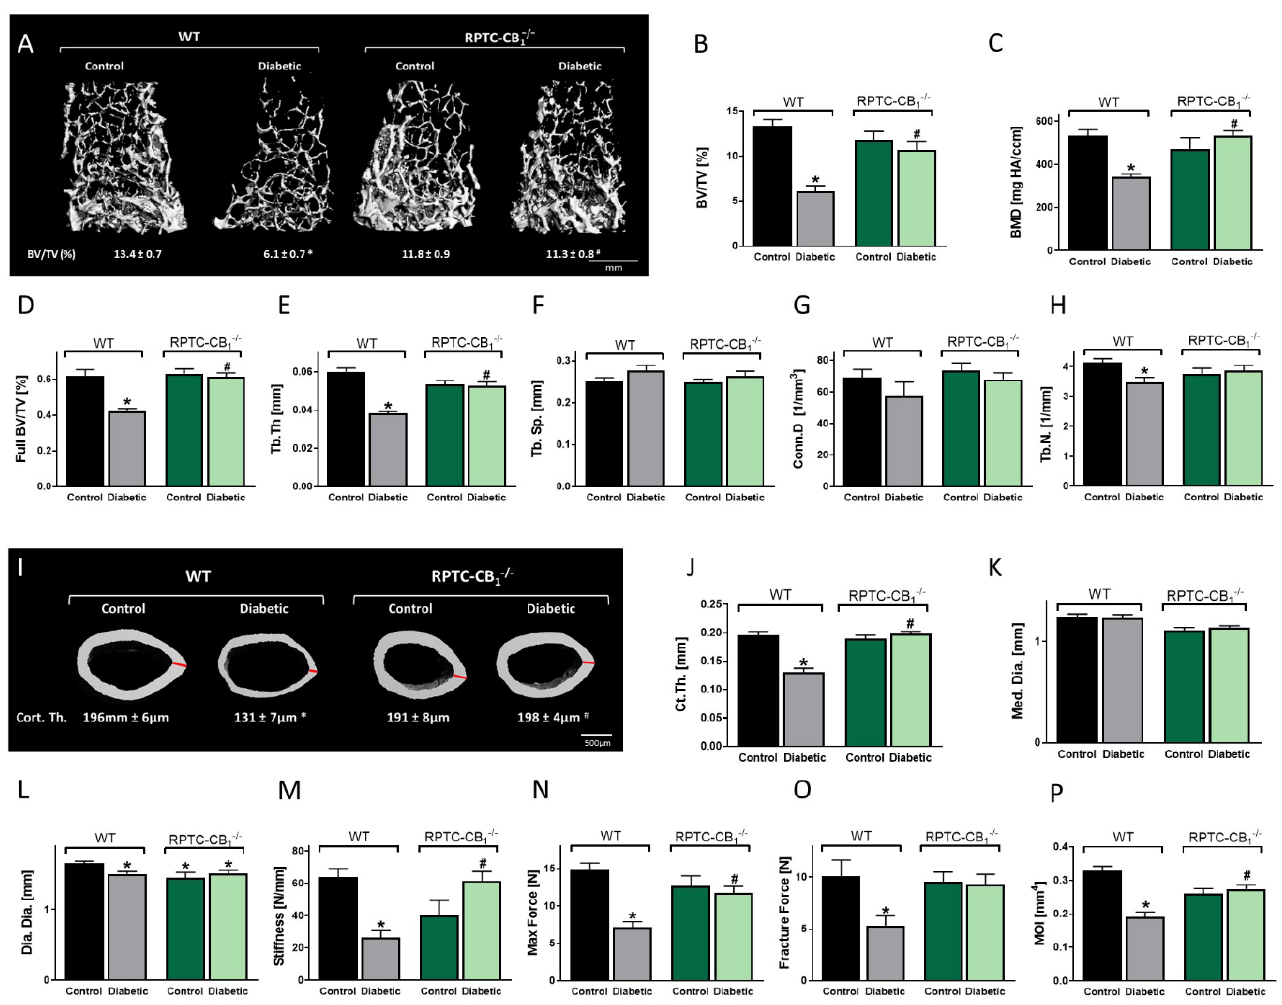
Figure 2. Nullification of CB 1 R in RPTCs protects against diabetes-induced bone loss. 3D images of the distal femoral metaphysis of RPTC-CB 1 − / − mice and their littermate WT controls with median bone volume fraction (BV/TV) values ( A , B ), bone mineral density (BMD; C ), full bone BV/TV ( D ), trabecular thickness (Tb.Th; E ), trabecular spacing (Tb.Sp; F ), connectivity density (Conn.D; G ), and trabecular number (Tb.N; H ). 3D images of the femoral mid-diaphysis of mice with median values of cortical thickness (Ct.Th) for each group ( I ), cortical thickness (Ct. Th; J ), medullary diameter (Med.Dia; K ), diaphyseal diameter (Dia.Dia; L ), stiffness ( M ), maximal force ( N ), fracture force ( O ), and moment of inertia (MOI; P ). Data represent the mean ± SEM from 8–13 animals per group, * p < 0.05 vs. non-diabetic WT control mice, # p < 0.05 vs. diabetic WT mice.